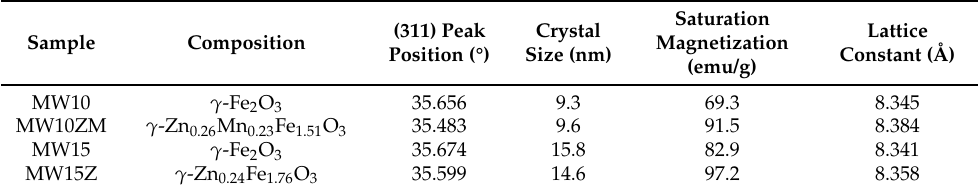
Table 1. Elemental composition and angular position of the the peak due to the (311) crystallographic plane, crystal size, saturation magnetization, and lattice constant value of the selected samples MW10, MW10ZM, MW15, and